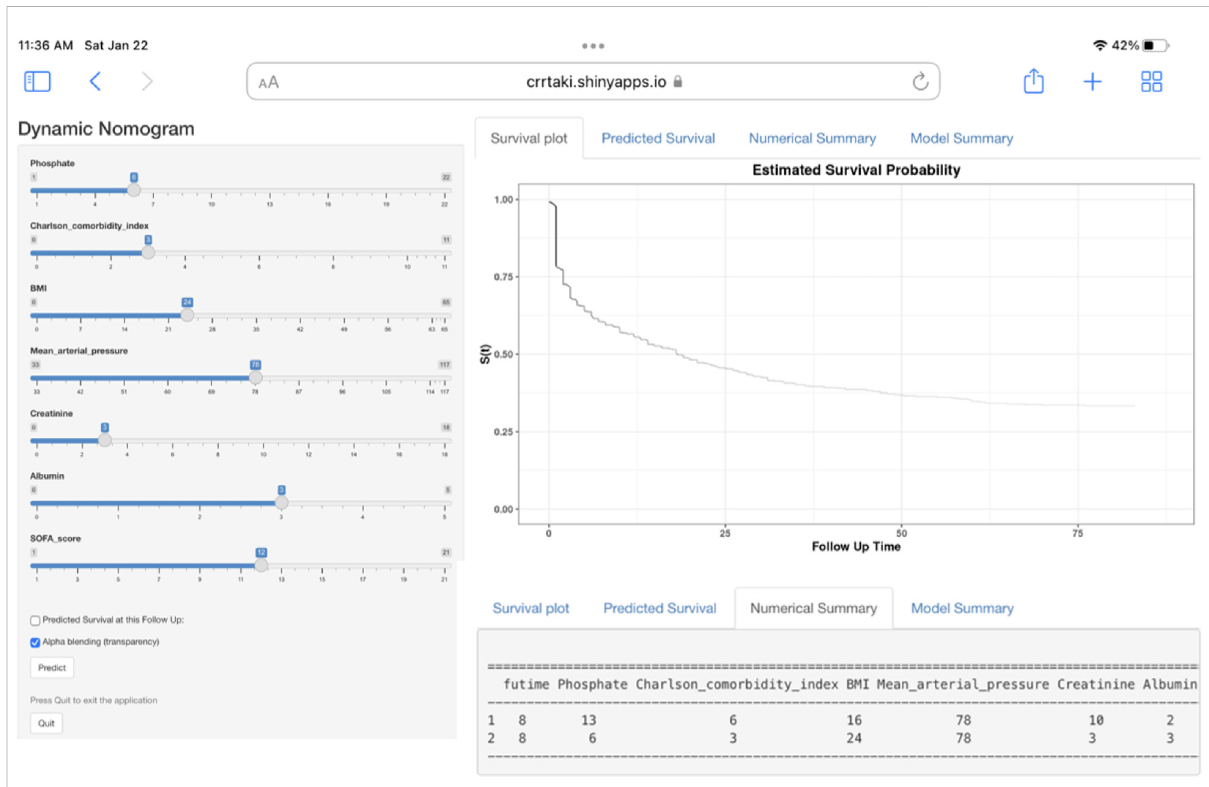
FIGURE 3 Web-based dynamic nomogram for estimating the probability of short-term mortality. By entering the speci fi cs of the acute kidney injury participant receiving continuous renal replacement therapy into the web-based program, we determined the participant ’ s short-term all-cause death probability (Entering Interface: This interface allows you to enter participant-speci fi c information. Short-term all-cause death probability, as depicted graphically in part,